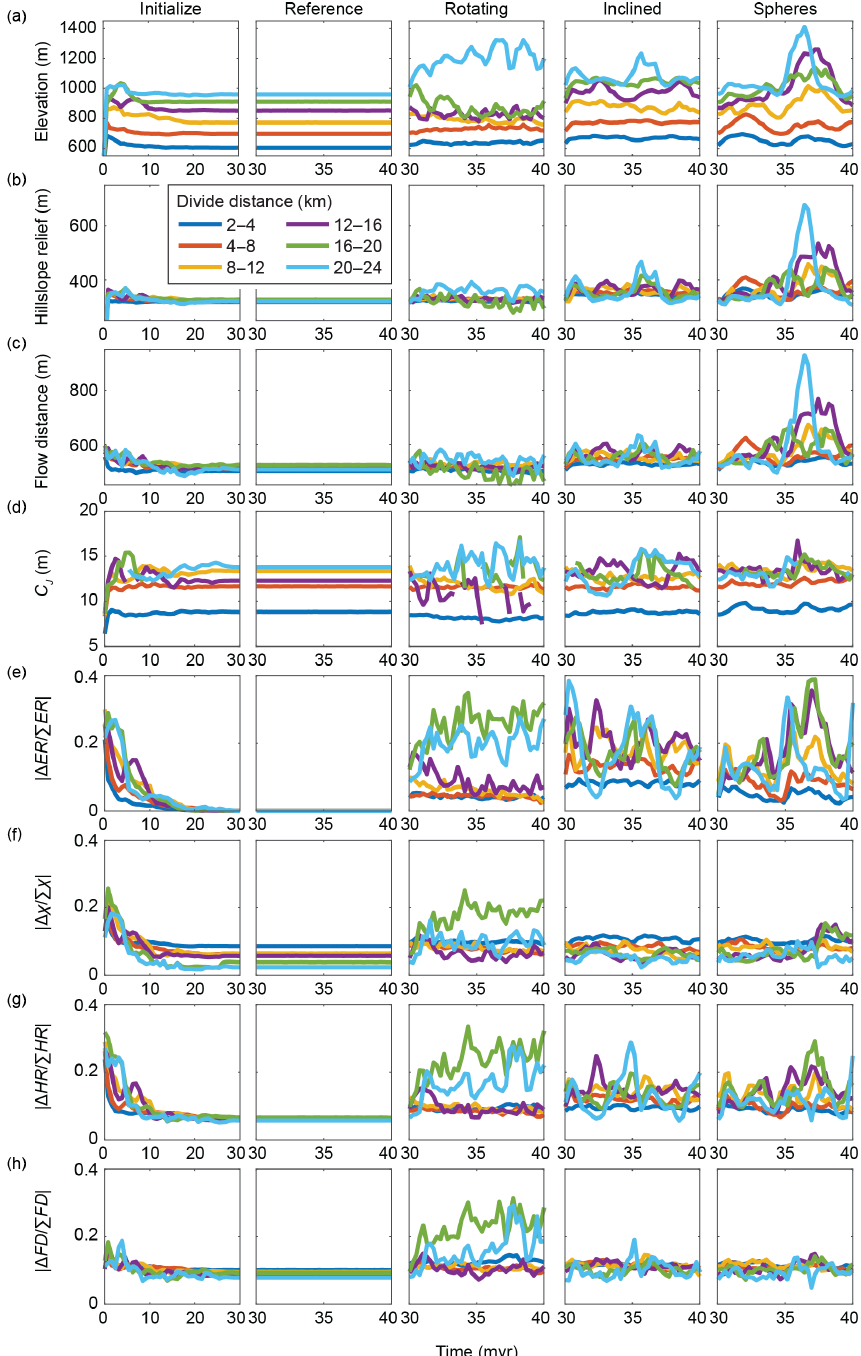
Figure 8. Temporal evolution of the drainage divide network during the landscape evolution experiments. Colored curves show mean values for divide segments at different divide distances. (a) Elevation. (b) Hillslope relief (HR). (c) Flow distance (FD). (d) Junction connectivity ( C J ). (e) Across-divide difference in erosion rate ( | (cid:49) ER /(cid:54) ER | ). (f) Across-divide difference in chi ( | (cid:49)χ/(cid:54)χ | ). (g) Across-divide differ- ence in hillslope relief ( | (cid:49) HR /(cid:54) HR | ), which is equal to the divide asymmetry index (DAI). (h) Across-divide difference in flow distance ( | (cid:49) FD /(cid:54) FD |